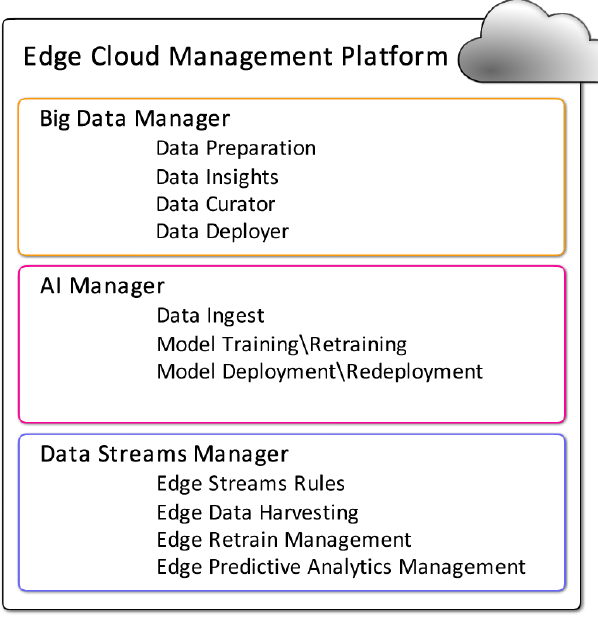
Figure 10. Edge cloud management platform.